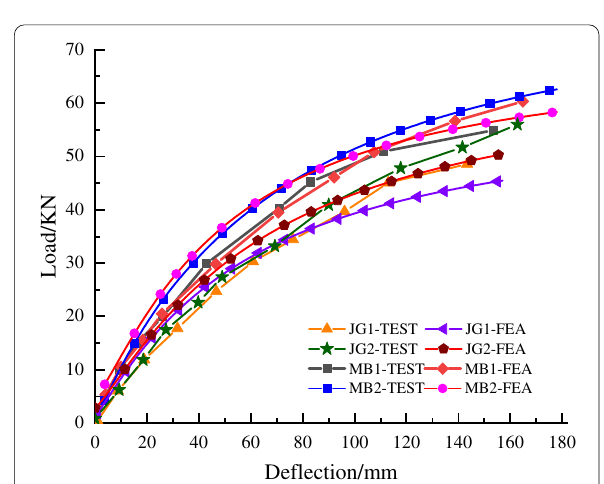
Fig.16 Curves of load–deflection of reinforced